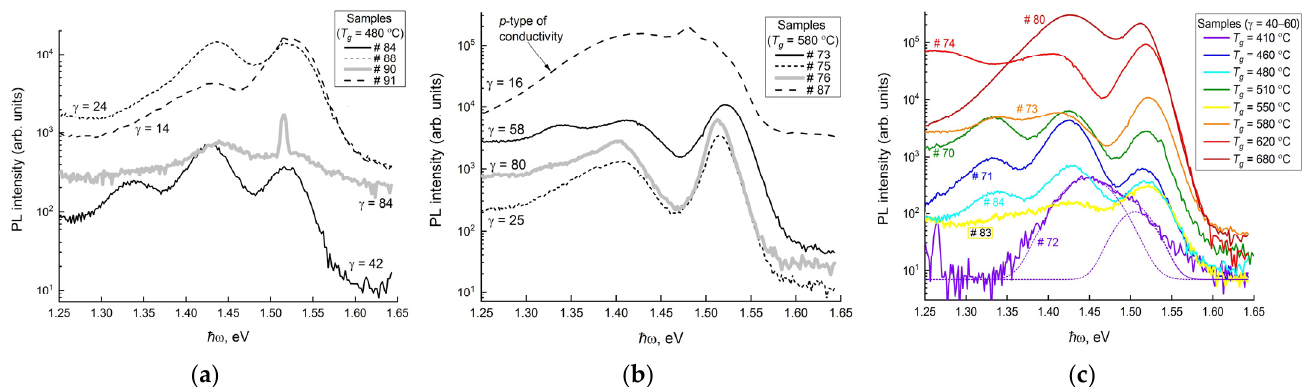
Figure 6. PL spectra: ( a ) samples grown at 480 °C; ( b ) samples grown at 580 °C; ( c ) samples grown at intermediate V/III ratio γ = 40–60 (the γ values are marked near all the curves, the growth temperature T g is shown in colors, sample #87 with holes is marked by an arrow, spectrum of sample #72 is decomposed on the two Gaussians for visualizing).